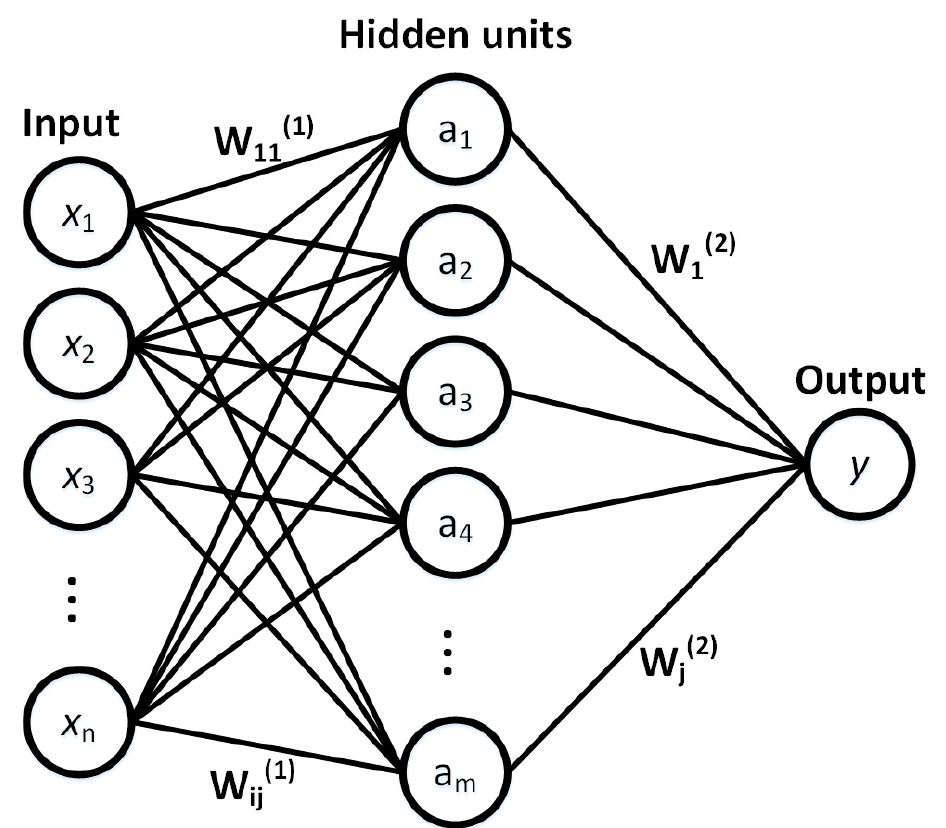
Figure 5. An overview of the artificial neural network (ANN) method. Symbol x represents an input feature, W ij(1) are the weights of predictors (normalized LiDAR metrics) to calculate intermediate values, a j is the intermediate value (hidden layer value) of neuron j , obtained from the activation function, W j(2) are the weights of the neurons in the calculation of the prediction, and y is the predicted DBH value. In this ANN, there is one hidden layer.